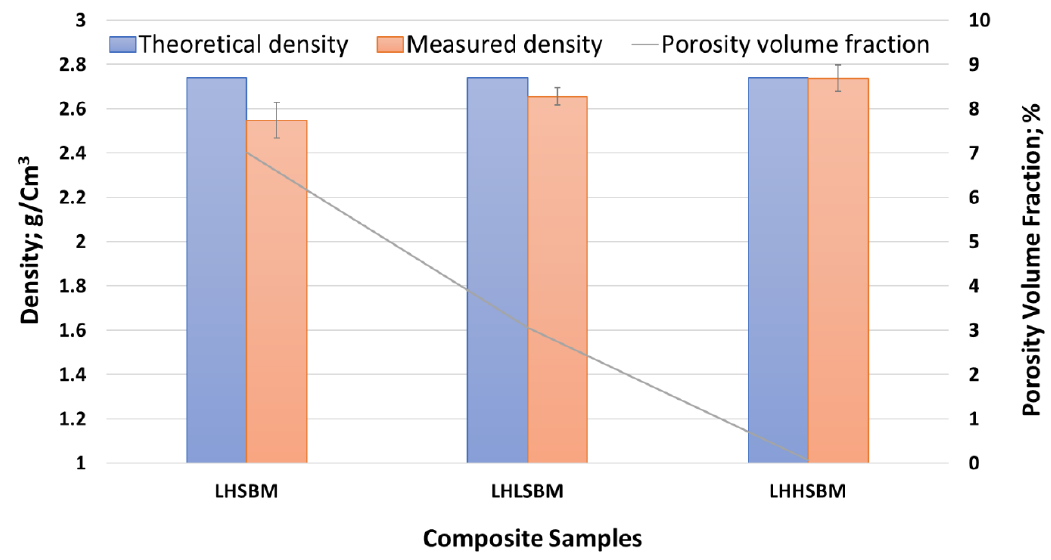
Figure 11. Theoretical and experimental densities of aluminum/SiC composites together with their porosity volume fraction.